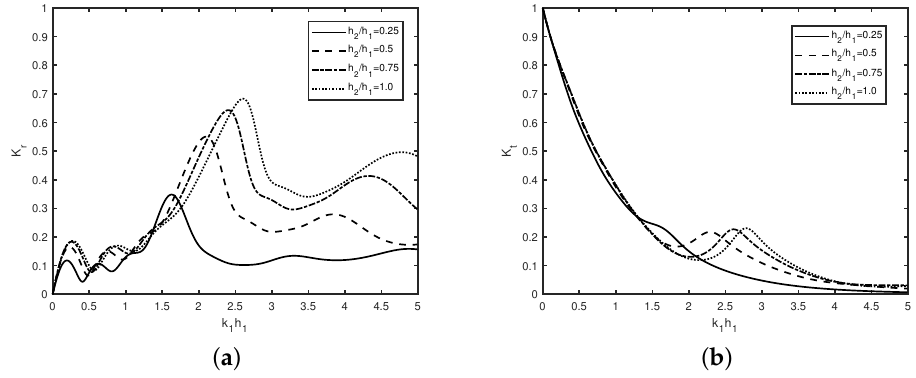
Figure 5. Variation of ( a ) reflection coefficient K r , and ( b ) transmission coefficient K t versus wavenum- ber k 1 h 1 for different h 2 / h 1 with C f = 0.5, w / h 1 = 1, d / h 1 = 2, θ = 20 ◦ , N = 4, h 1 = 5